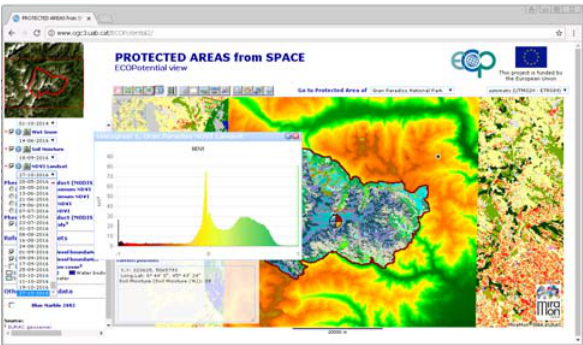
Figure 7. Screenshot showing the histogram representation over the NDVI dataset for the Gran Paradiso National Park for a particular date.